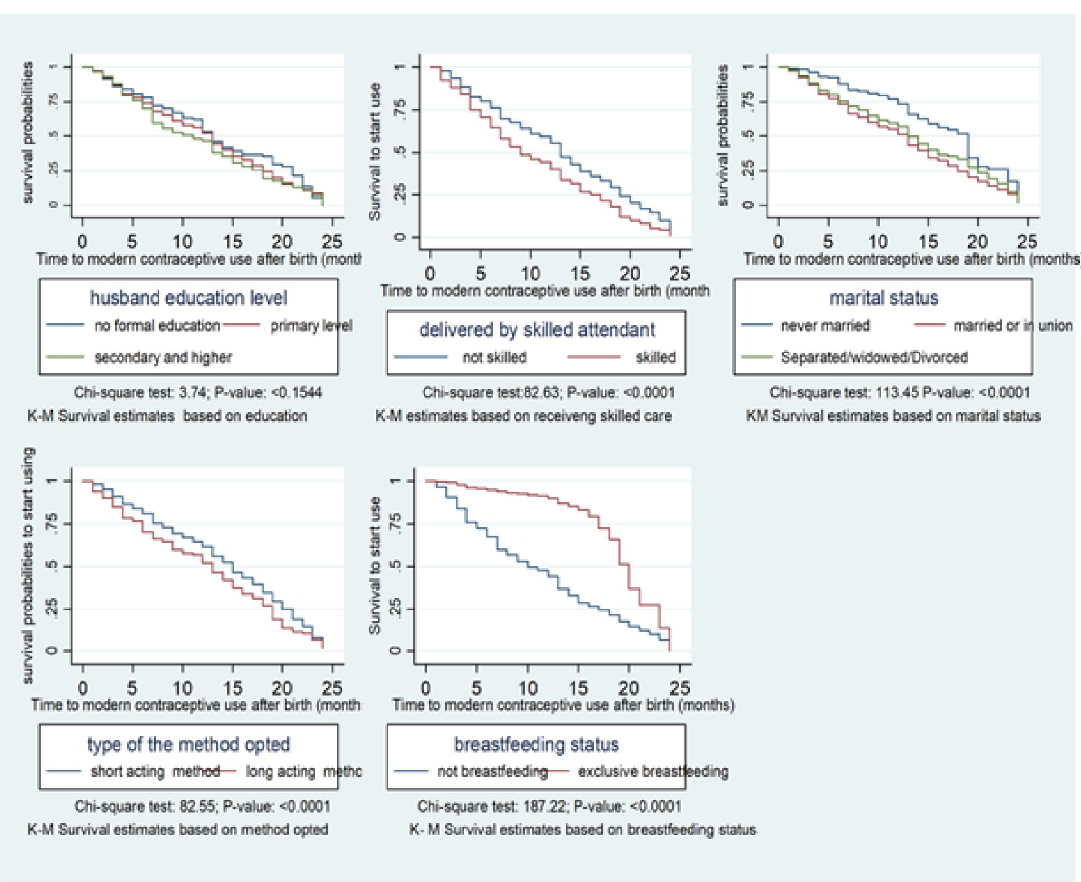
Fig 5. Differentials in time to modern contraceptive use after